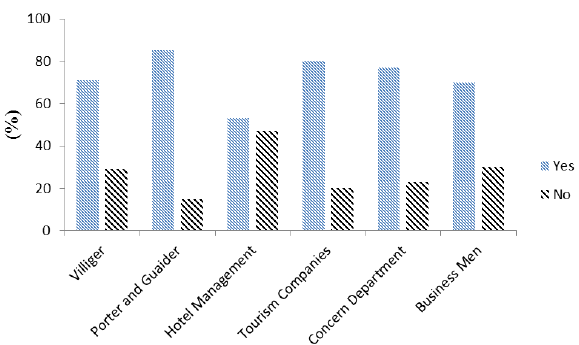
Fig. 3. Opinions about pollution of water resources due to tourist activities